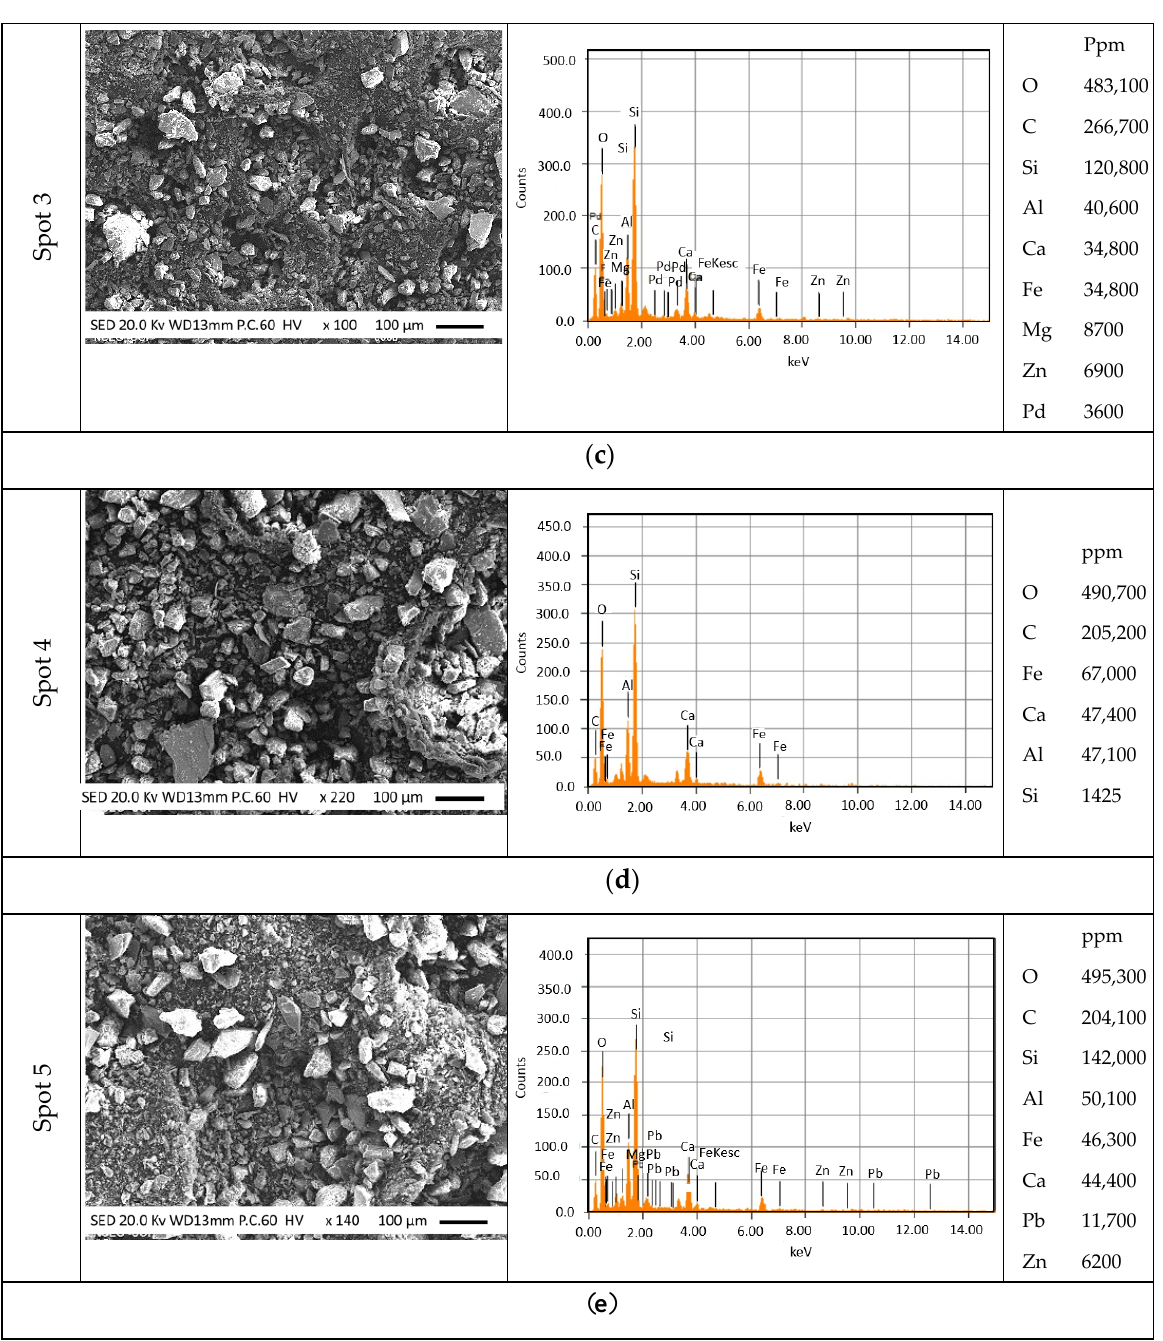
Figure 3. SEM and EDS images of Lowari tunnel dust: ( a ) Spot 1; ( b ) Spot 2; ( c ) Spot 3; ( d ) Spot 4; ( e ) Spot 5.